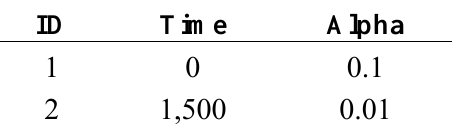
Table 2 Predefined adjustment tables for α